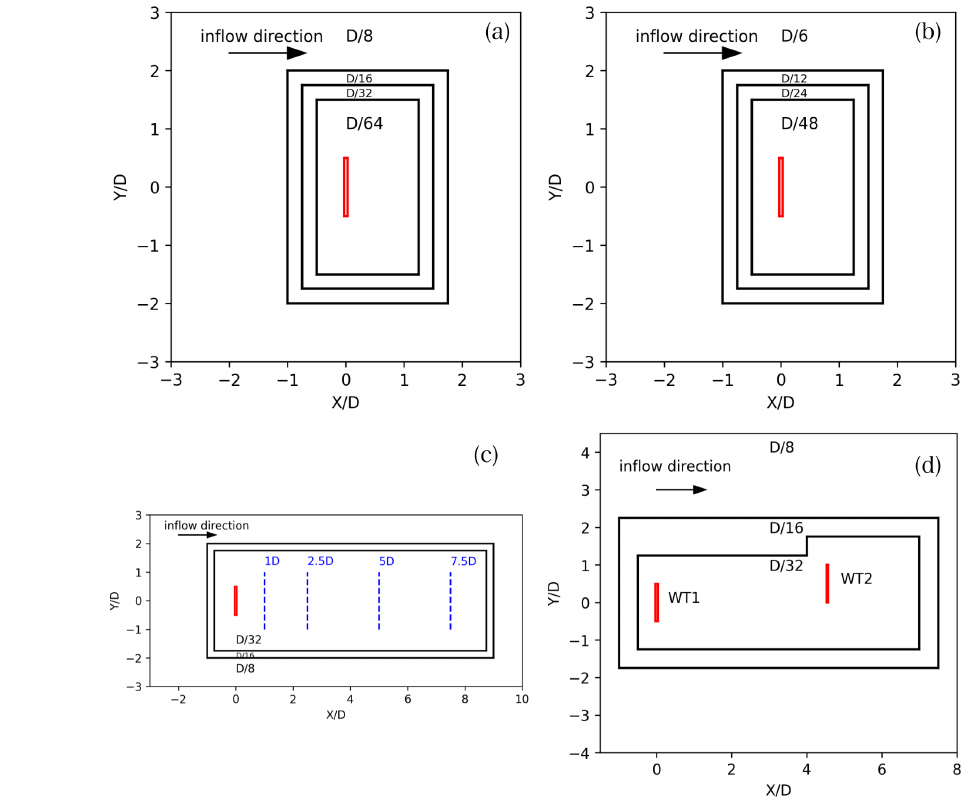
Figure 2. Horizontal domain size and cell size in the mesh refinement zones for the non-turbulent inflow cases: (a) and (b) for the mesh sensitivity analysis and (c) for the wake analysis with a single turbine. In (d) the domain for the double-WT layouts is shown. The only difference between the single-turbine cases is the cell